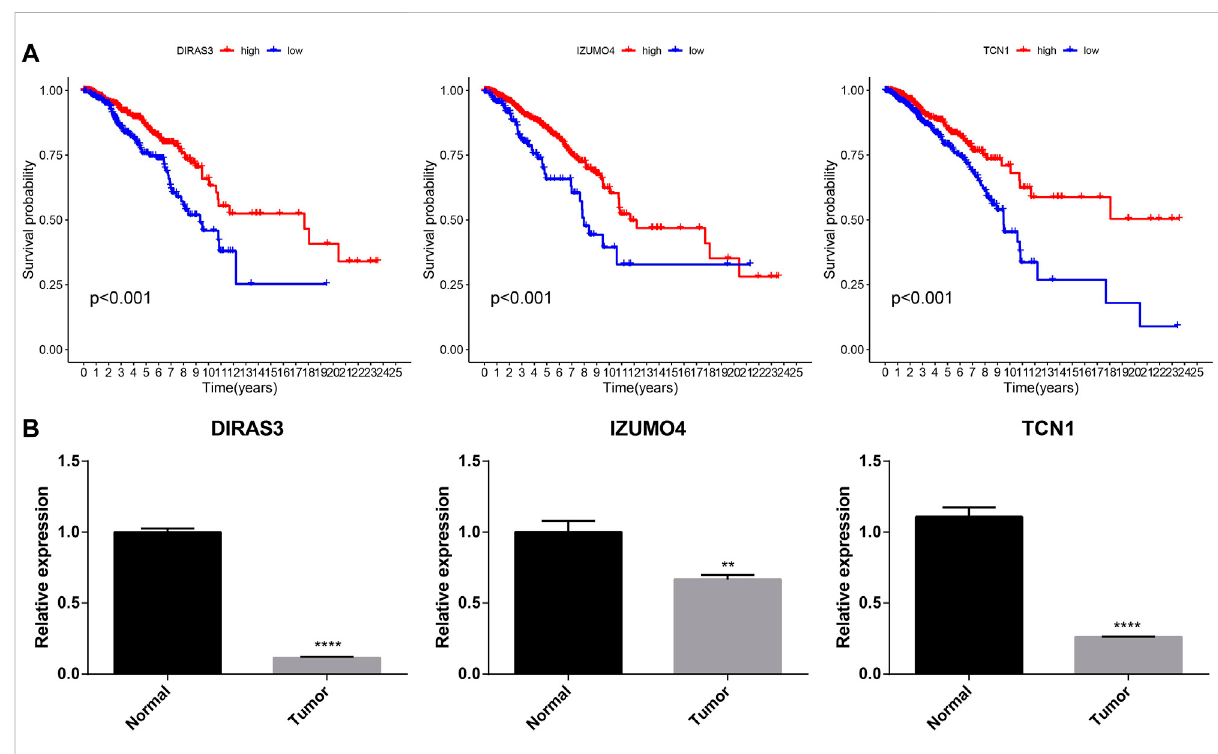
FIGURE 11 Prognosticand RT-qPCR validation of DIRAS3 , IZUMO4 , and TCN1 . (A) Kaplan – Meier survival analysisfor DIRAS3 , IZUMO4 , and TCN1 in BC. (B) RT-qPCR of DIRAS3 , IZUMO4 , and TCN1 in normal breast epithelial and BC